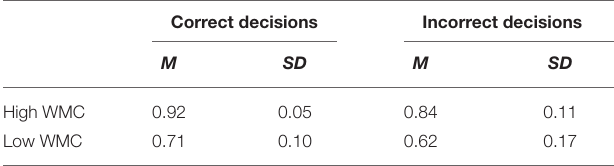
TABLE 4 | Mean confidence in overall word recall performance and monitoring index scores for high and low WMC